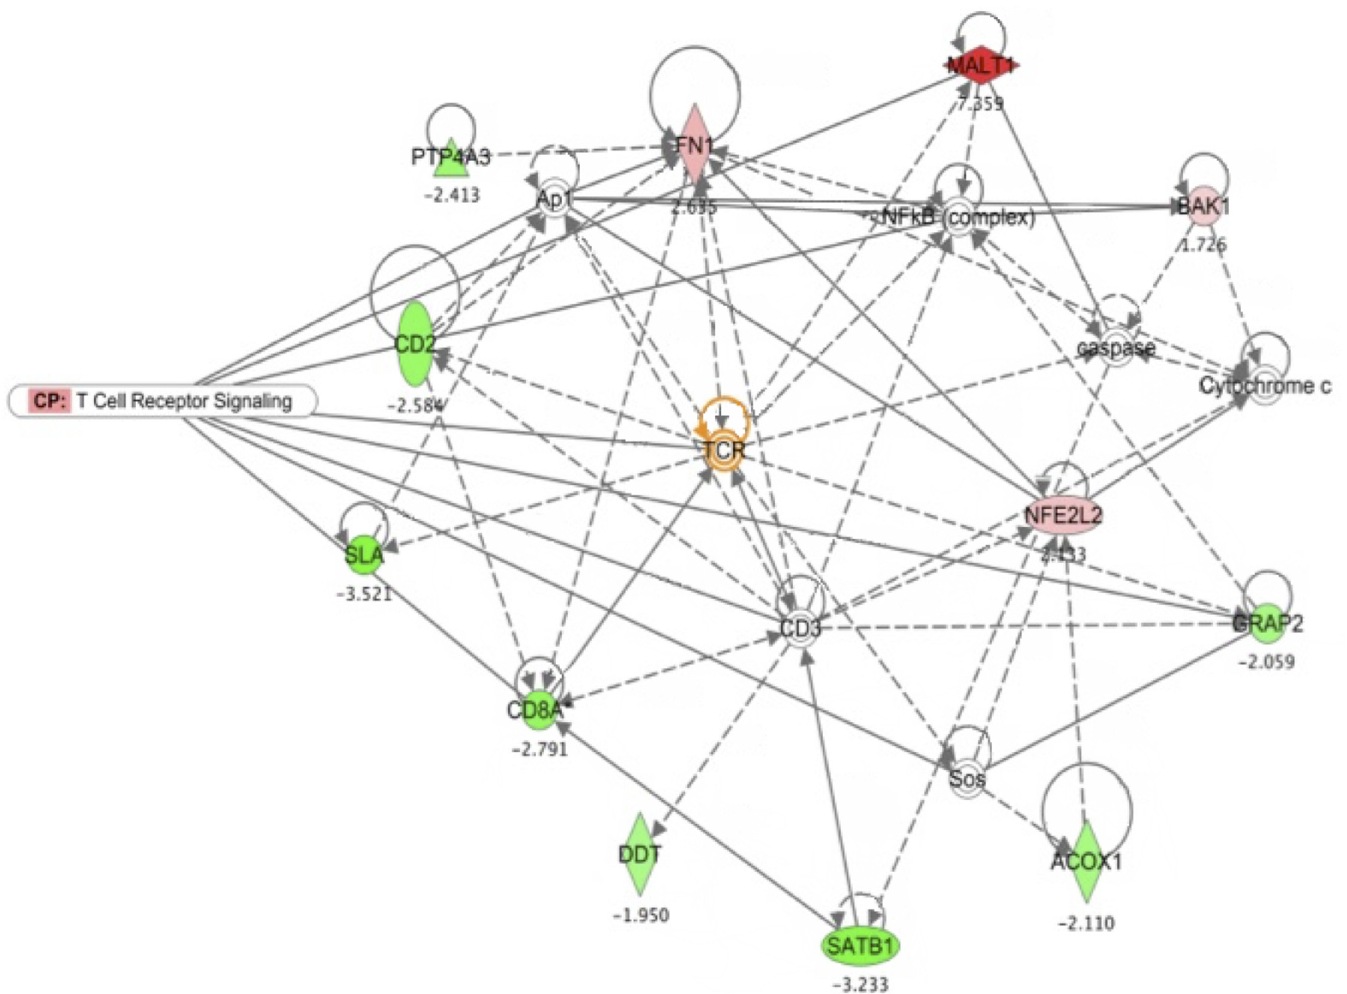
Fig 2. T-cell receptor signalling was the most significant gene network of over-expressed genes in infected samples of thymus as identified by Ingenuity Pathway Analysis (www.ingenuity.com). Colored nodes represent differentially regulated genes (Table 4) while genes in uncolored nodes were not identified as differentially expressed and were integrated into the computationally generated network indicating a relevance to it (S1 File). T-cell receptor signalling gene relationships were overlaid to the network. Solid interconnecting lines represent genes directly connected and dotted lines signify the indirect connection between genes and cellular functions. Top functions of the genes were related to T-cell receptor signalling, immune response and cellular assembly and death, identified around the MALT1 gene (in red). Node shapes represent different biological molecules.